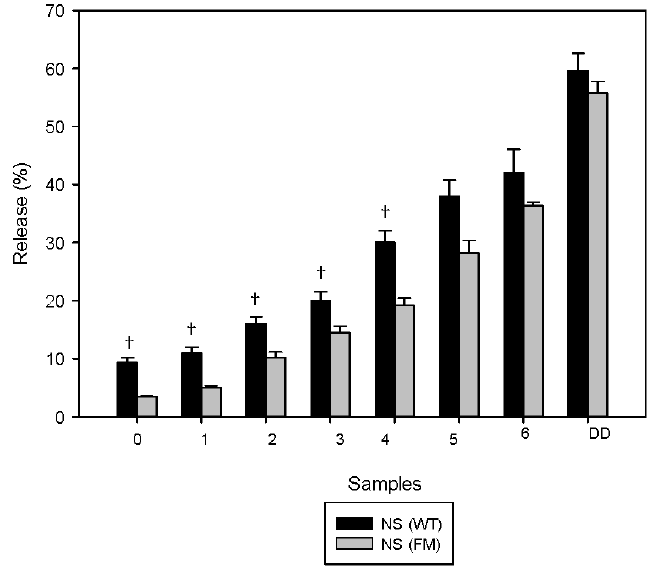
Figure 3. Kinetic of release of flavan ‐ 3 ‐ ols from natural almond skin (NS) in water ( A ) and full ‐ fat milk ( B ). Values are given as % of flavan ‐ 3 ‐ ols released from the initial amounts of flavan ‐ 3 ‐ ols in the meals (Table 2) during in vitro gastric (samples 0 to 6, see Table 1 for sampling time) and gastric + duodenal (DD) digestion. Values represent averages (±SD) of triplicate measurements. SD were always <10%. Water (WT), full ‐ fat milk (FM). † p < 0.01 vs. NS (FM).